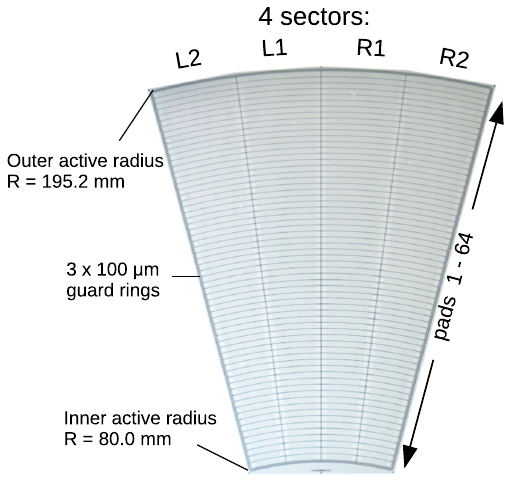
Fig. 2 A LumiCal silicon sensor Fig. 3 Detector plane assembly. The thickness of adhesive layers (not